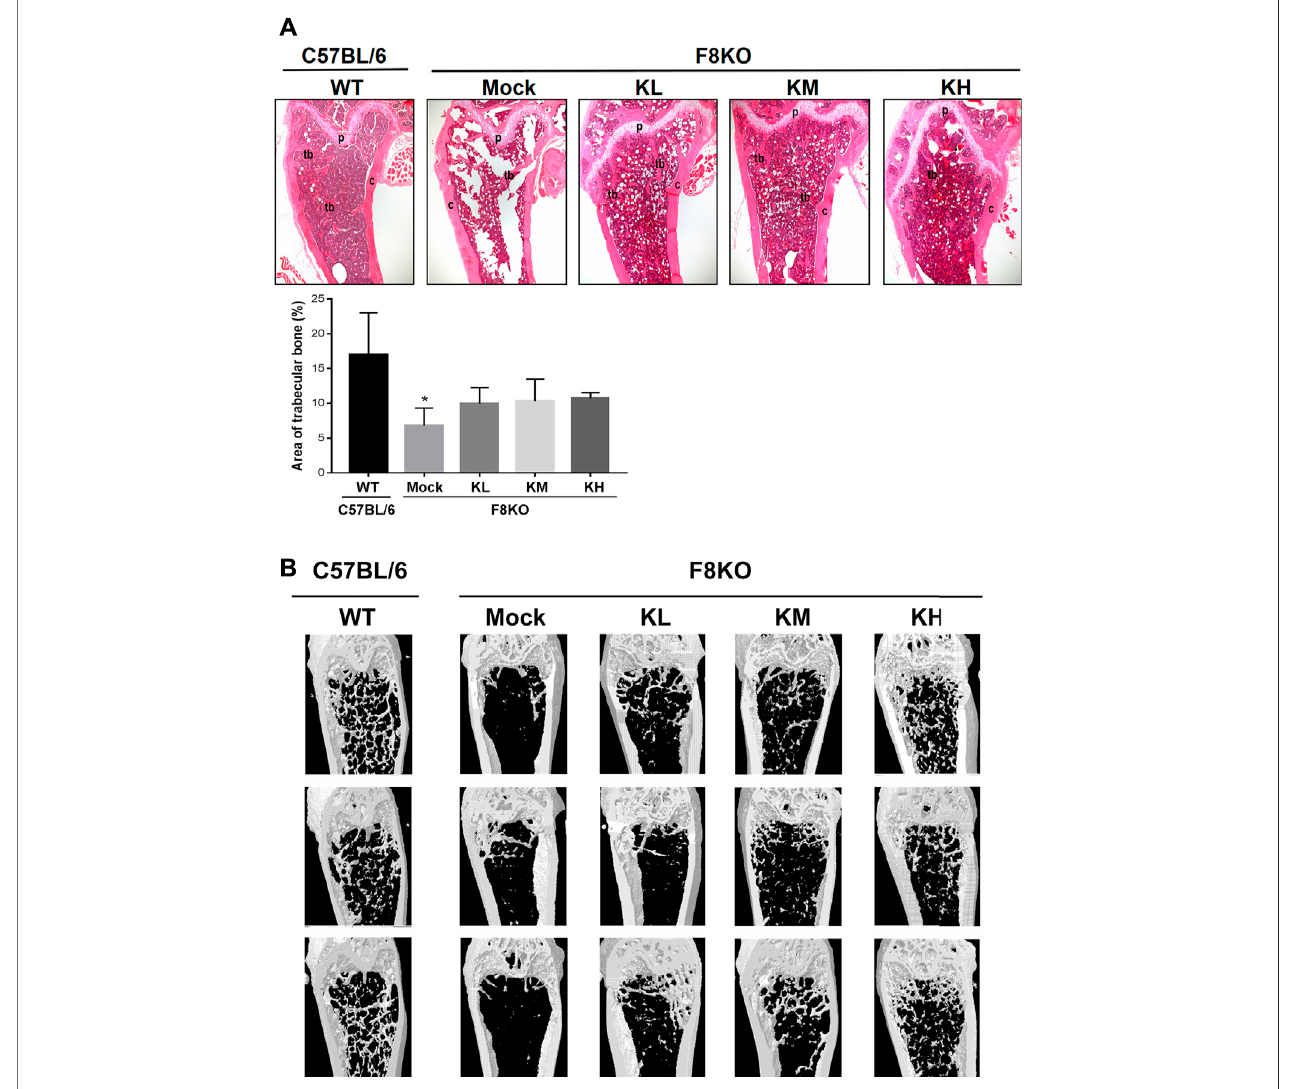
FIGURE 2 | Femur bone histopathological and microarchitectural changes in osteoporotic F8KO mice after ke fi r peptide (KP) treatment. (A) Representative H&E stainingimages offemurverticalsectionsofmaleF8KOmice aftertreatmentwithdifferentdosages ofKPsfor8 weeks( n =8).C57BL/6Jwild-type(WT)micewereused asanormalcontrol.The areaoftrabecularbone intheH&Eimageswerequanti fi edusing ImageJ software asindicated. Tb, trabecular bone;C, cortical bone;P,growth plate. * p < 0.05 vs WT group. (B) Representative μ -CT 3D images of distal femur vertical sections of male F8KO mice after different dosages of KP treatment for 8 weeks ( n = 8). The C57BL/6J wild-type (WT) group indicates normal trabecular bone morphology in the distal femur, and the F8KO mock group indicates server trabecularbonelossasahemophilia-inducedosteoporoticmouse.KL:low-doseKP-treatedgroup,164 mg/kg/day;KM:medium-dose KP-treatedgroup,328 mg/kg/ day; KH: high-dose KP-treated group, 656 mg/kg/day.